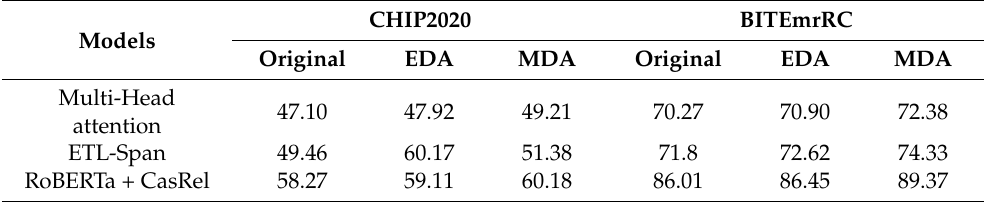
Table 6. F1-score of the RC task on the CHIP2020 dataset and the BITEmrRC dataset.